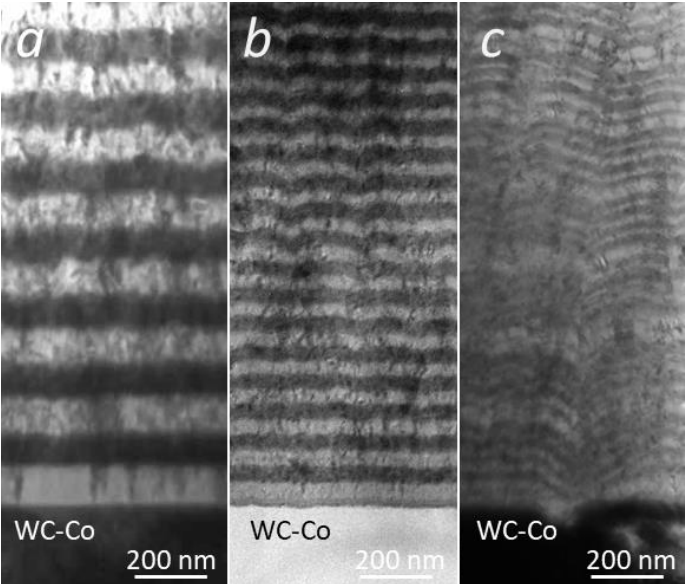
Figure 2. Cross-sectional TEM images of NL-TiAlN/CrN hard coating with a typical columnar grain growth and sputter deposited on cemented carbide substrates. The samples were prepared in the same batch but rotated around a different number of axes: ( a ) one-fold, ( b ) two-fold and ( c ) three-fold rotation. The magnification scales are identical.